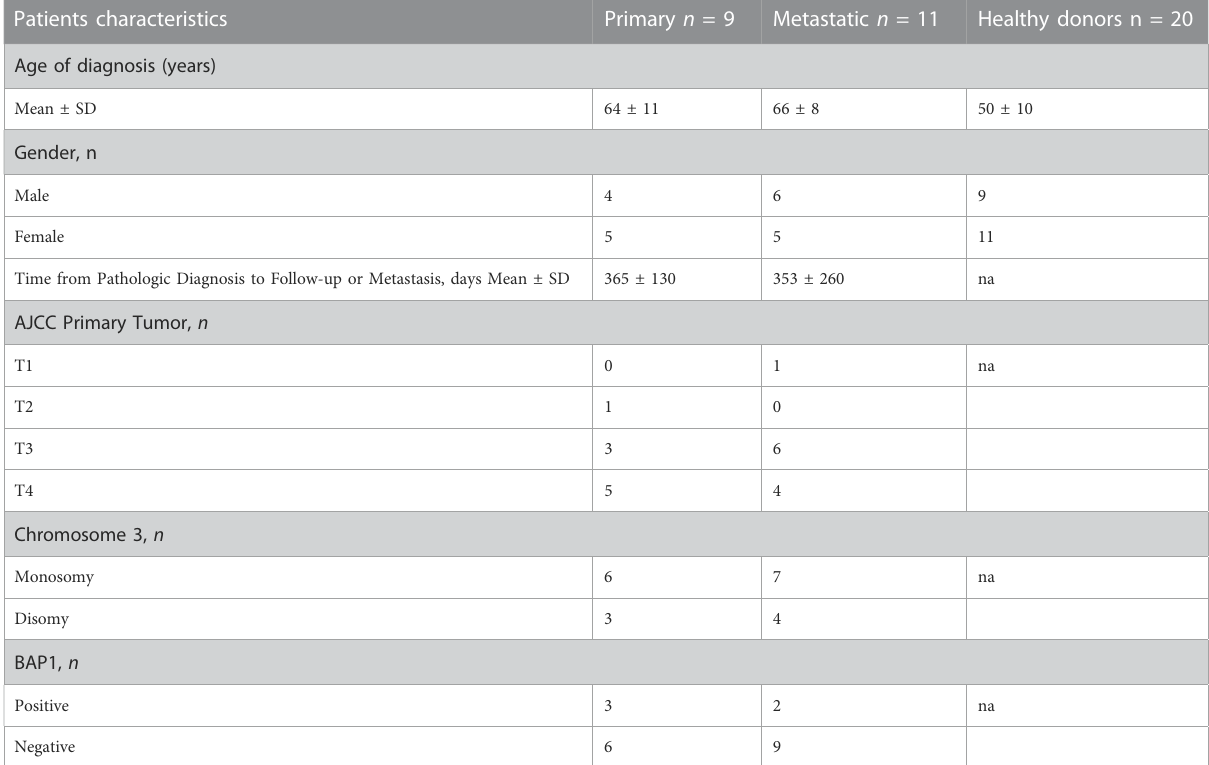
TABLE 1 The clinical, histopathological, and molecular characteristics of distinguished subgroups of studied primary tumor samples collected from uveal melanoma (UM) and healthy donors. na – not applicable. Patients